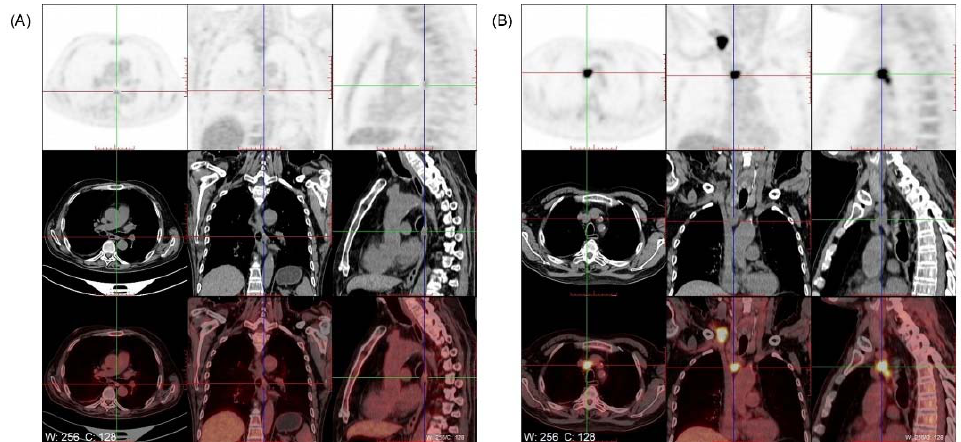
Figure 3. 18F ‐ FDG ‐ PET of the patient. ( A ) Esophageal cancer (after treatment): High accumulation in the middle ‐ lower esophageal section with a maximum SUV of 3.8. ( B ) Lymph node metastasis: High accumulation in the mediastinum lymph node (region 2R 1.8 cm × 2.2 cm) with a maximum SUV of 17.8.